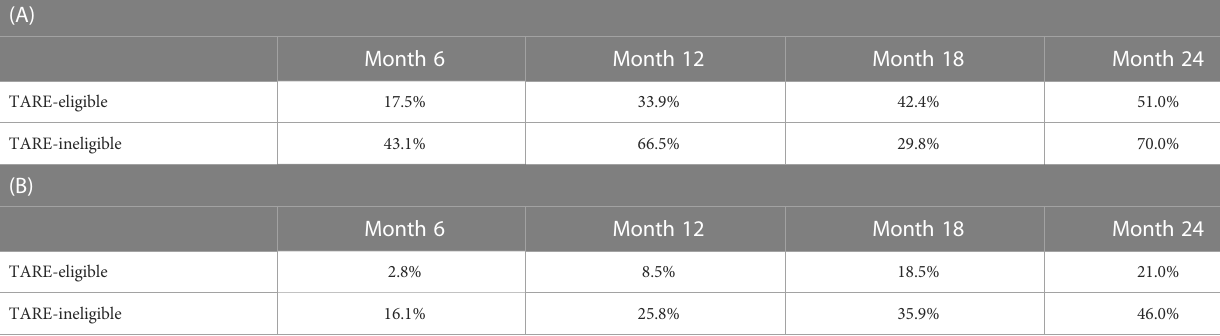
TABLE 2 The risk of (A) progression or (B) death at selected landmark time